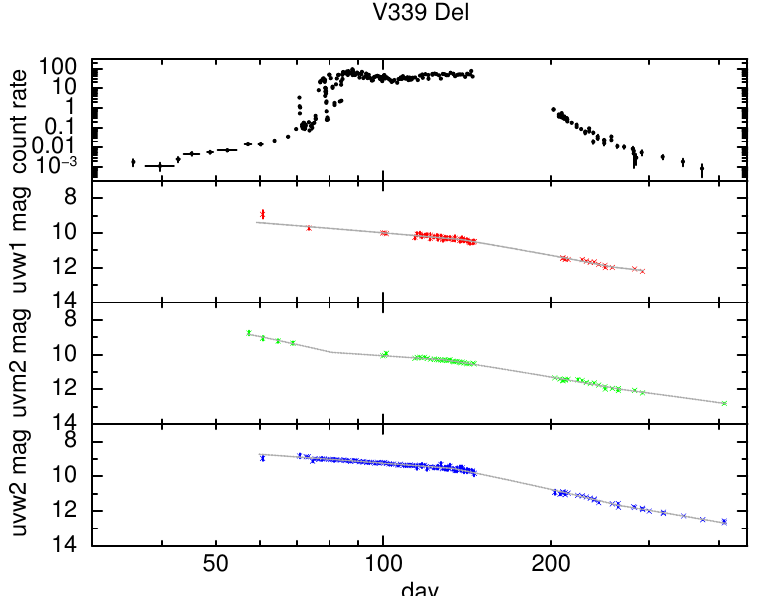
Figure 7. The XRT and UVOT light-curves of V339 Del, with the best-fit broken power-law declines shown as the grey solid lines. The X-ray data (top) are in count s − 1 over 0.3–10 keV.